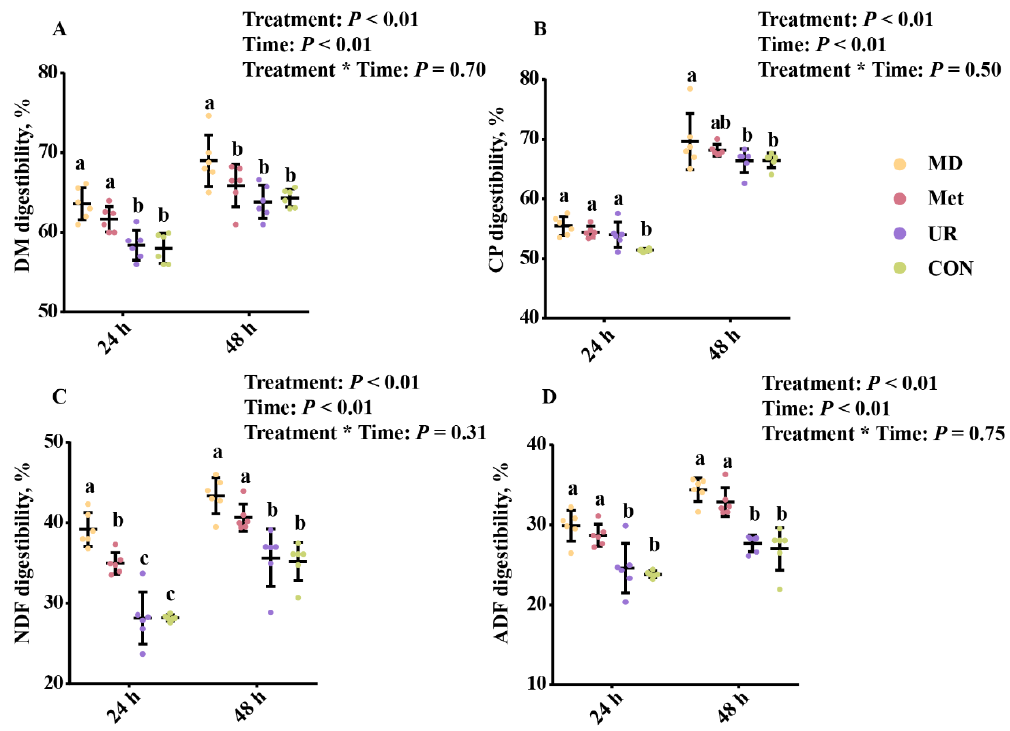
Figure 1. Effects of urea, methionine, and methionine dipeptide on in vitro digestibility of dry matter ( A ), crude protein ( B ), neutral detergent fiber ( C ), and acid detergent fiber ( D ) of total mixed ration at 24 h and 48 h. CON = no additive, UR = urea addition, Met = methionine addition, and MD = methionine dipeptide addition. Means with different letters (a–c) at a given time are significantly different ( p < 0.05). Vertical bars denote standard deviation (SD). DM, dry matter; CP, crude protein; NDF, neutral detergent fiber; ADF, acid detergent fiber; n = 6 per treatment per